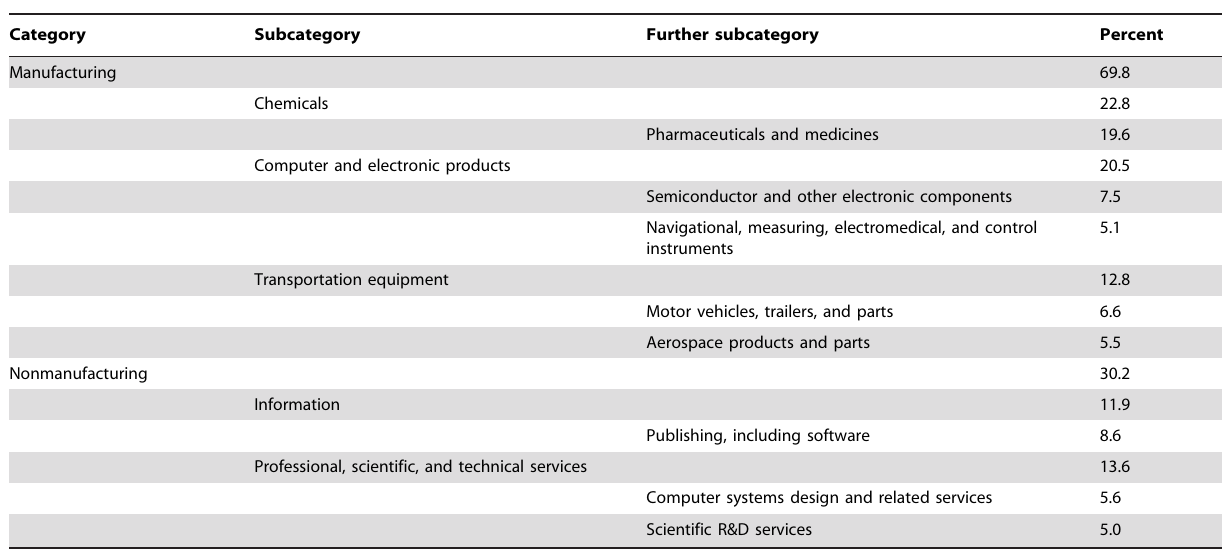
Table 2. Breakdown of industry spending on R&D in